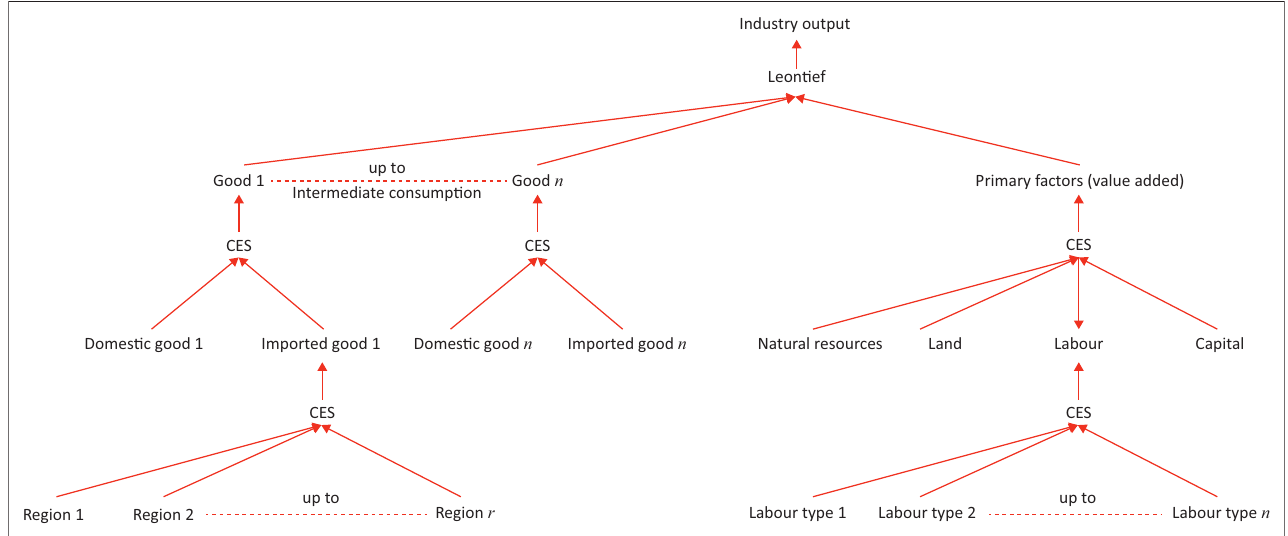
FIGURE 1: Structure of production in the GDyn